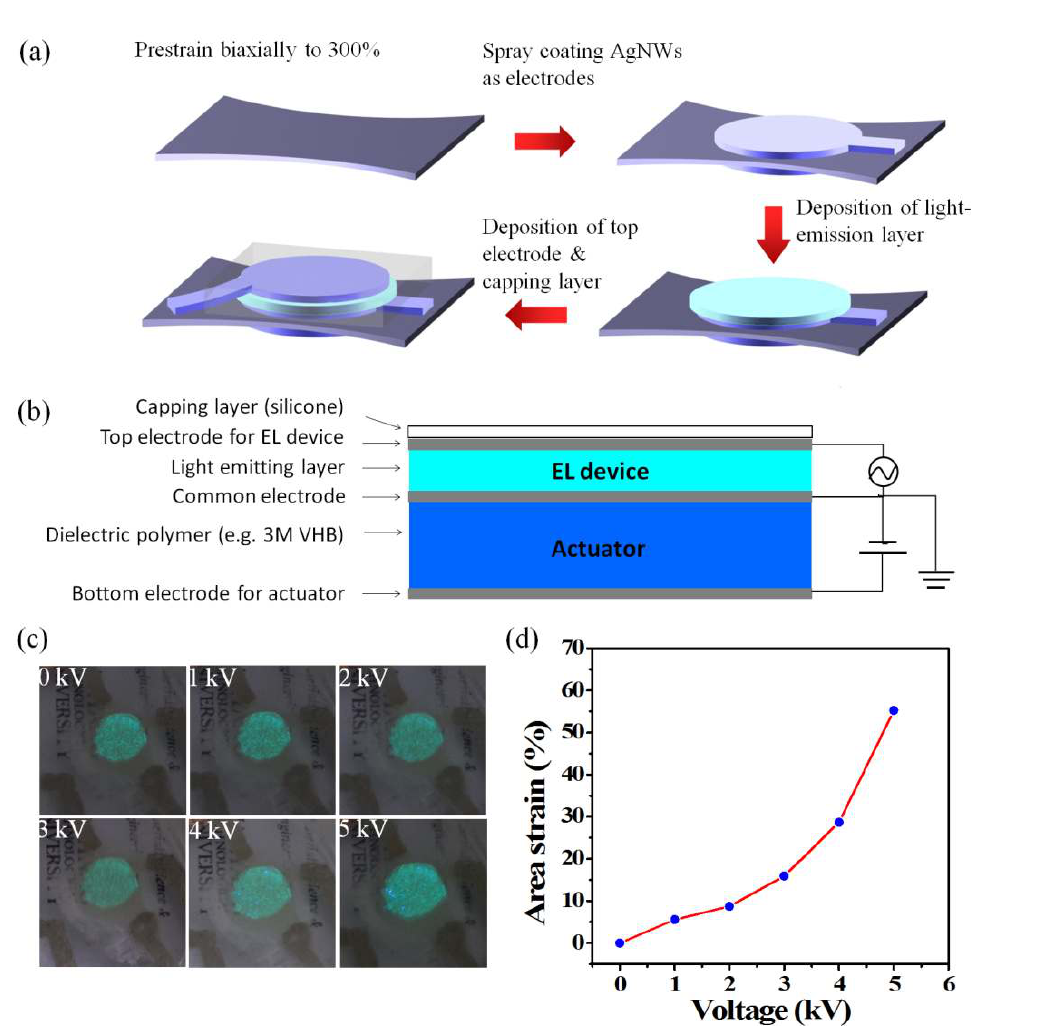
Figure 10: Schematic images of the self-deformable ACEL device: (a) the device fabrication procedure and (b) the cross-sectional view of the device. (c) Photographs of the self-deformable ACEL devices actuated under different bias. (d) Electrical actuating performance of the device. Reproduced with permission from